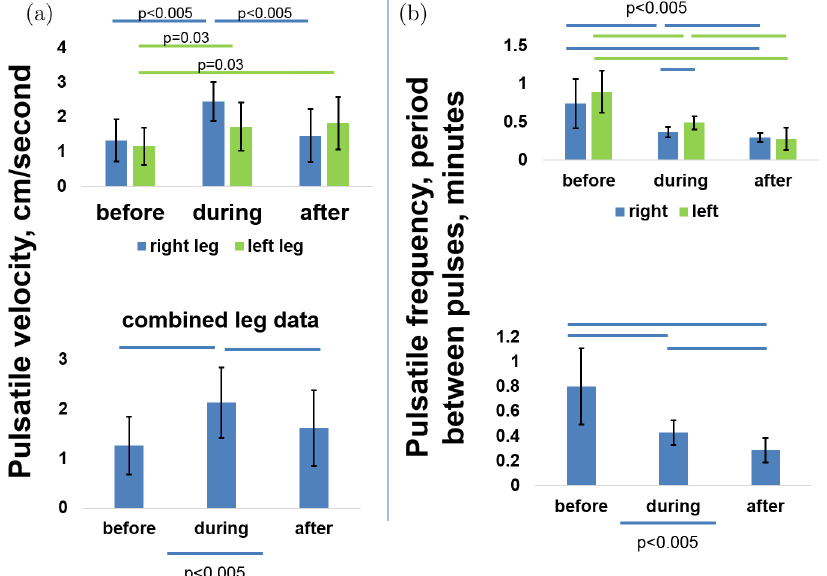
Fig. 10. Pulsatile velocities and frequencies increased with PCT in subject 3. (a) Lymphatic vessel pulsatile velocities (centimeters/ minute) and frequencies (expressed in periods, or minutes between pulses) in left and right legs before, during, and after PCT, (b) data from both legs combined. Bars ¼ p < 0.005, unless otherwise